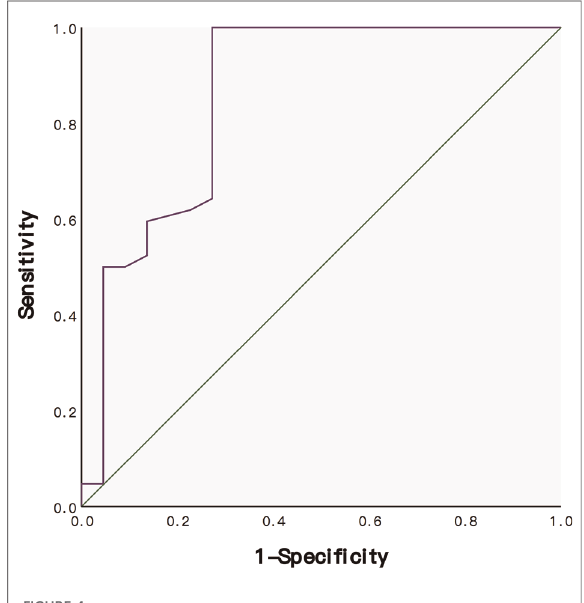
FIGURE 4 ROC curve for the sensitivity and speci fi city of HU values in predicting subsidence after ACCF. The AUC was 0.859.